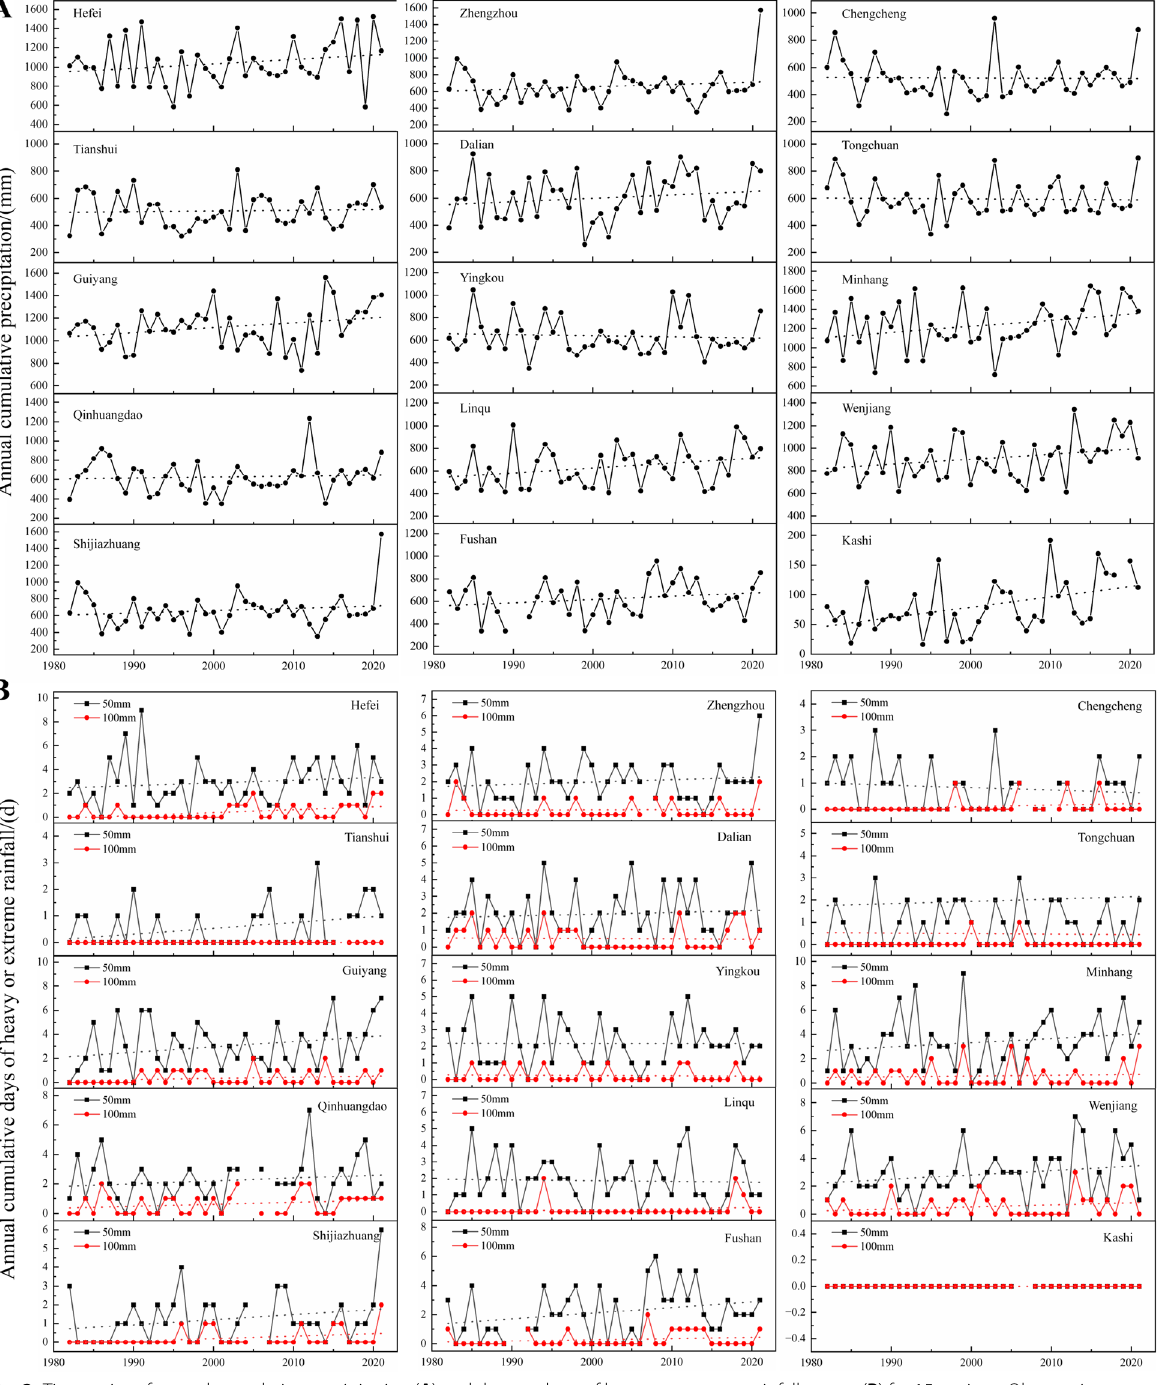
Fig. 2 Time series of annual cumulative precipitation ( A ) and the numbers of heavy or extreme rainfall events ( B ) for 15 stations. Observations are missing from several stations for some years. Dotted lines: the linear trends from